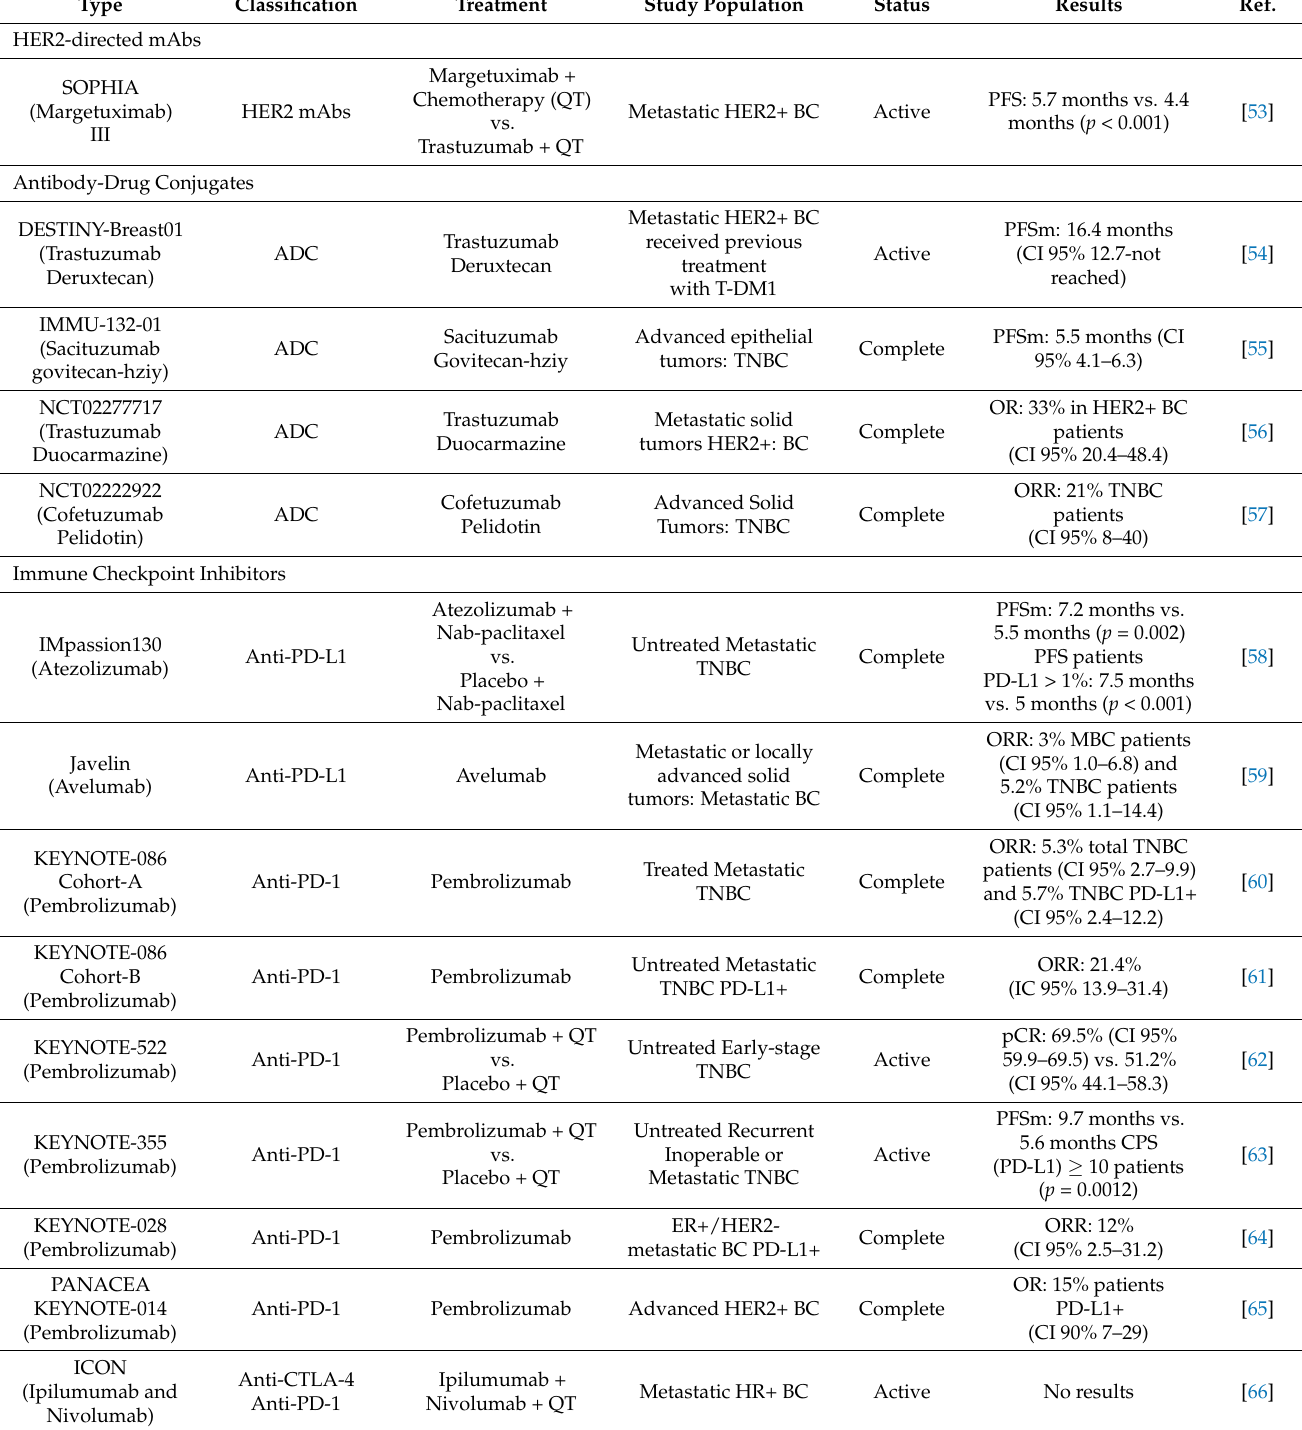
Table 1. List of the clinical trials that evaluated monoclonal antibodies, immune checkpoint inhibitors and antibody-drug conjugate in breast cancer